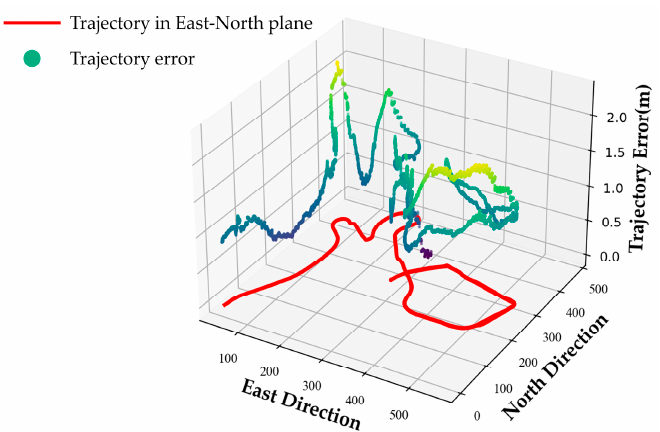
Figure 9. The 2D trajectory error of the complex environment on the East–North plane.